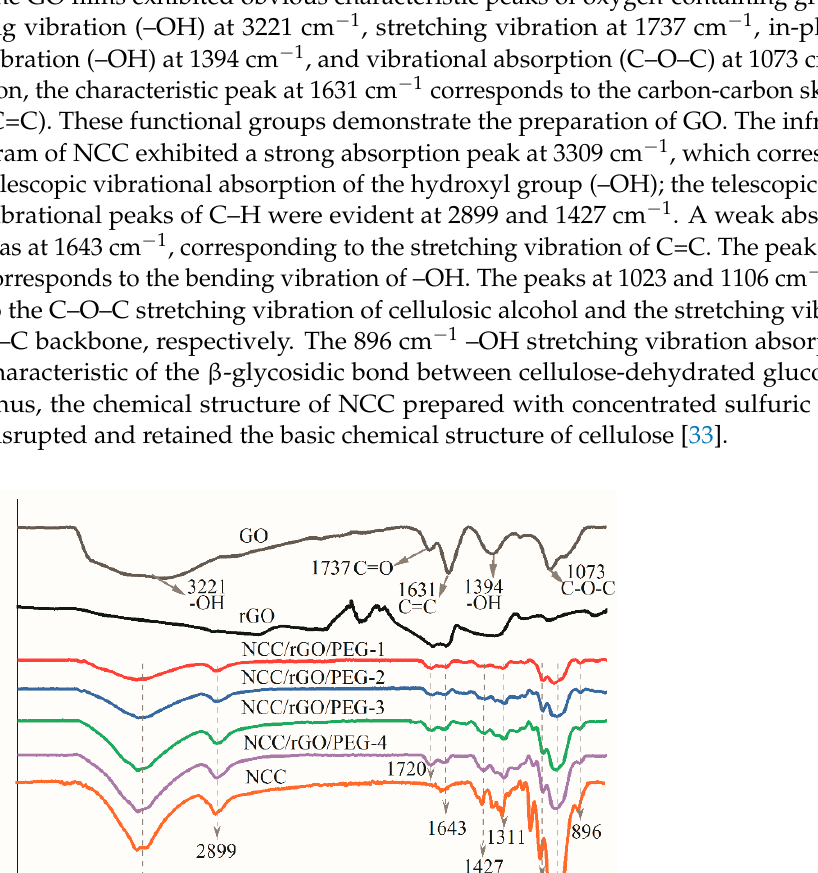
Figure 4. X-ray diffraction(XRD) spectrum of GO and the composite film.